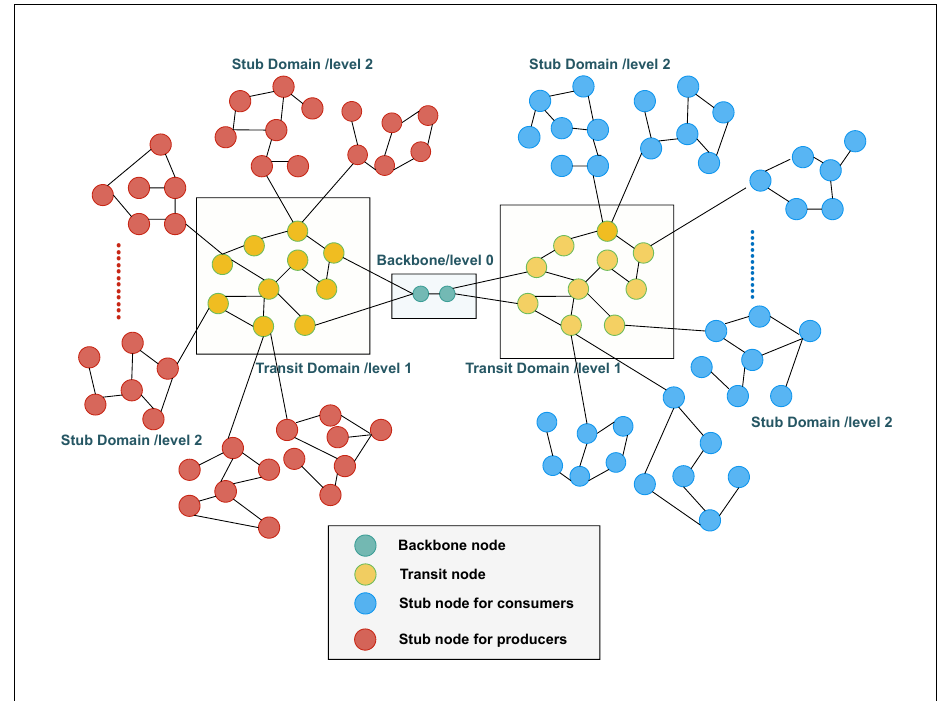
Figure 4. Transit Stub topology used in the